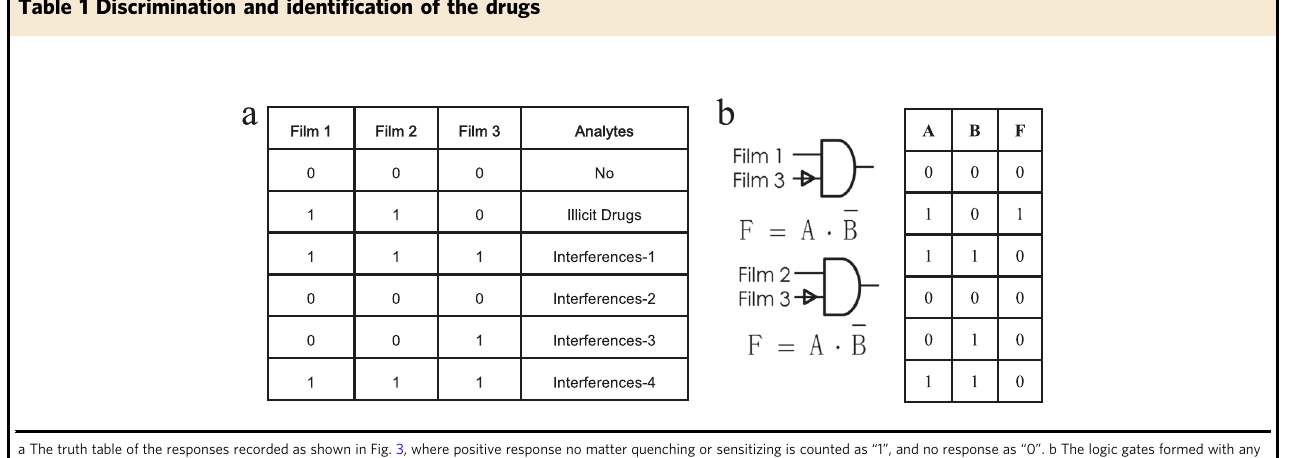
Table 1 Discrimination and identi fi cation of the drugs